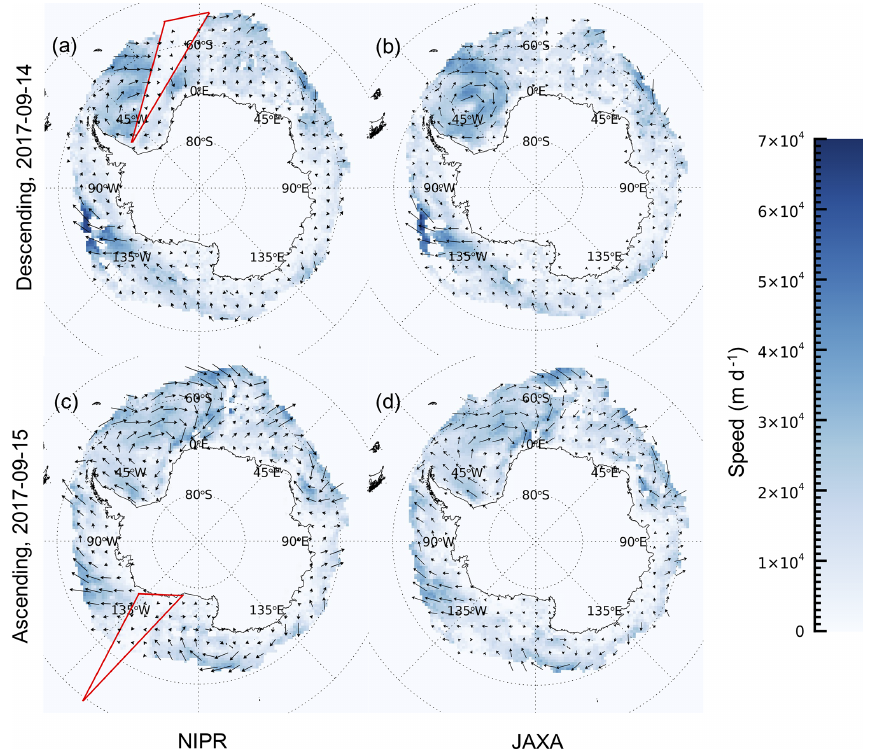
Figure 3. Sea ice speed (color scale) and velocity (vectors) from (a) the original KIMURA DES dataset (produced from the NIPR T B composite) and (b) the rectified KIMURA DES dataset (produced from JAXA T B composite) on 14 September 2017. Panels (c) and (d) : same as for (a) and (b) but for the ASC dataset on 15 September 2017. Vectors are subsampled by a factor of 5 to enhance visibility. Red triangular areas shown in (a) and (c) mark the regions of erroneously low velocity.